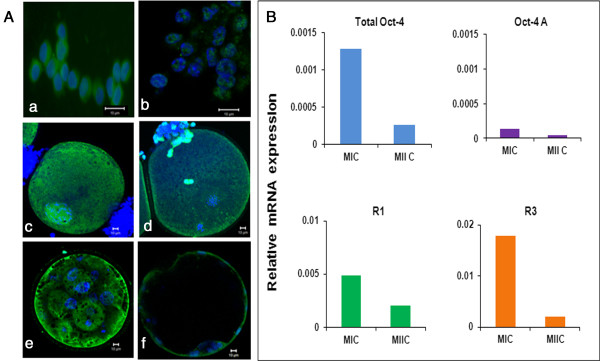
Immunolocalization and PCR of FSHR and OCT-4 in the granulosa cells, oocytes and embryo. (A) Confocal microscopy shows the presence of (a) FSH receptors and (b) OCT-4 in the cytoplasm of the granulosa cells (c-f) OCT-4 localization in MI and MII oocytes and early embryo. Note the MI oocyte shows both nuclear and cytoplasmic OCT-4 whereas in the MII oocyte OCT-4 was observed in the ooplasm in the 4–8 cells embryo and blastocyst OCT-4 was observed in the blastomeres surrounding trophoectodermal cells as well as in the inner cell mass. (B) qRT-PCR analysis of FSH receptor transcripts R1 and R3, Oct-4A and total Oct-4 in the granulosa cells surrounding MI and MII oocytes. R3 transcript mRNA is significantly highly expressed compared to the canonical R1 transcript in the granulosa cells. Note a reduction in all the transcripts in the granulosa cells collected from MII oocytes. Magnification is 40X and granulosa cells are image at 4X optical zoom. The relative expression of transcripts is a representation of pooled samples analyzed once.